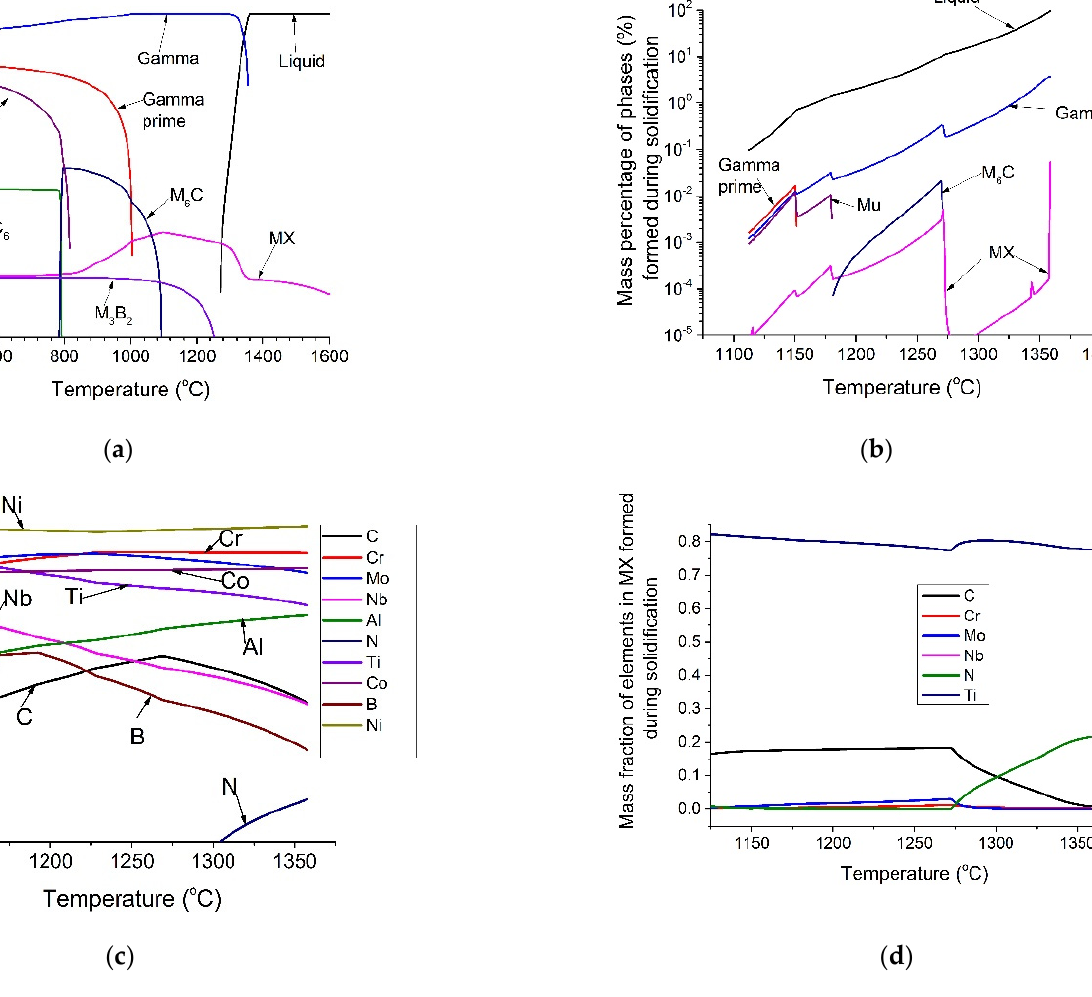
Figure 2. Thermodynamic predictions: ( a ) equilibrium state phase diagram, ( b ) solidification sequence, ( c ) element distribution in liquid during solidification, and ( d ) composition of predicted MX during solidification.